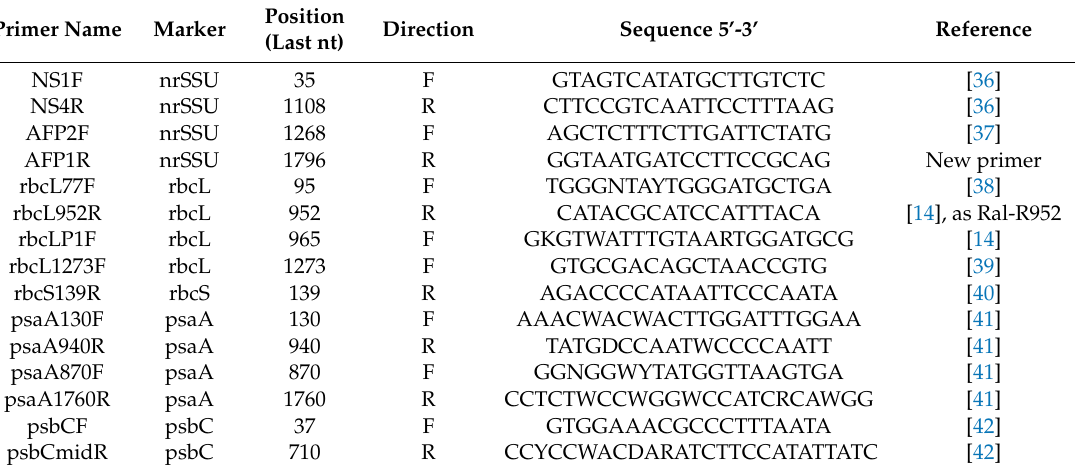
Table 1. Oligonucleotide primers used for PCR amplification and Sanger